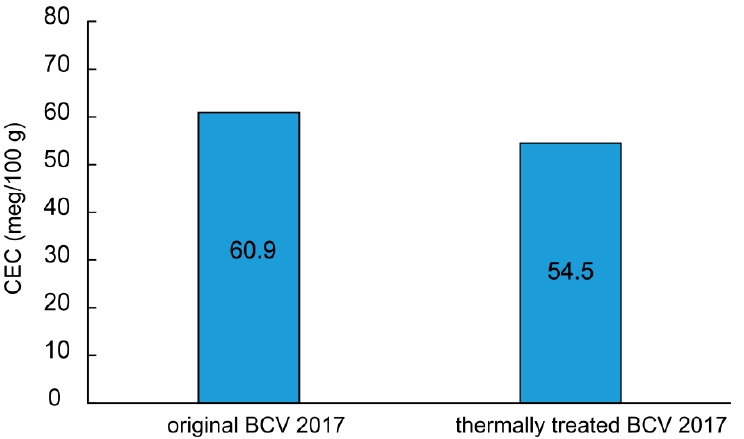
Figure 6. Cation exchange capacity (CEC) of the original and the thermally treated BCV 2017.